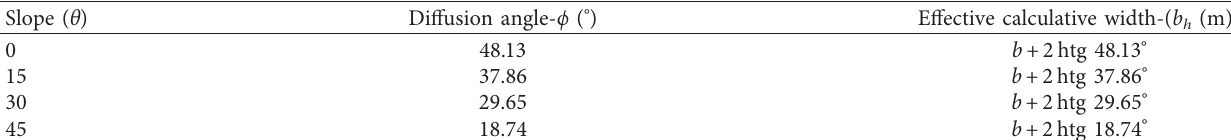
Table 5: Calculative width based on soil displacement.